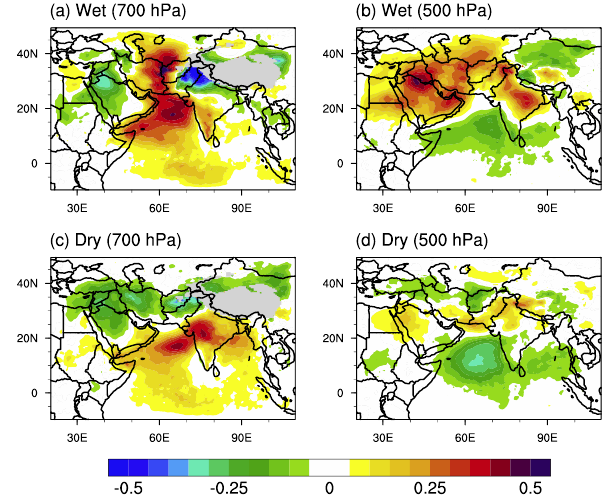
Figure 15. Spatial patterns of WRF-Chem simulated temperature differences (ALLF minus NDST; unit: K) in the “wet” subgroup at (a) 700hPa and (b) 500hPa, and in the “dry” subgroup at (c) 700hPa and (d) 500hPa. The ensemble members in the “wet” and “dry” subgroups are selected based on the rainfall responses in Fig. 8a, and include ensemble members of 1, 5, 12, and 14, and 2, 4, 6, and 8, respectively. No significant test is applied due to the small sample size of